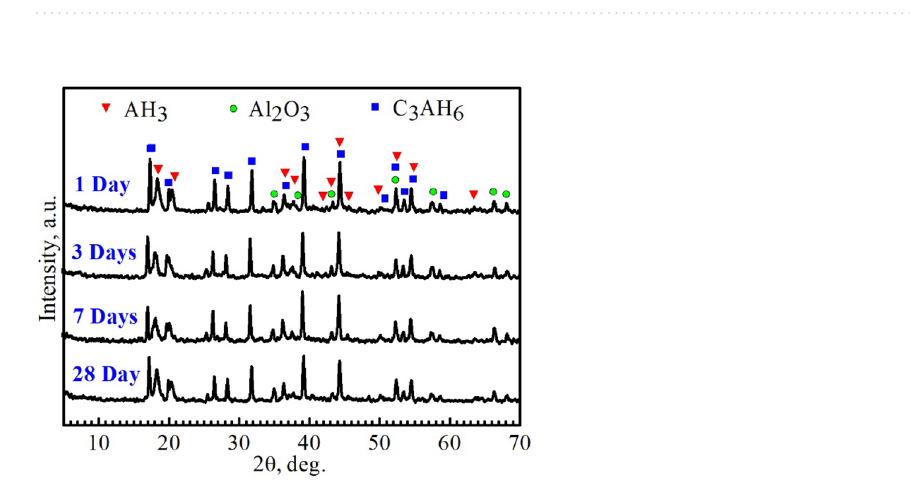
Figure 6. Compreesive strength of the compacted specimens sintered at 1250, 1350 °C and 1450 °C.